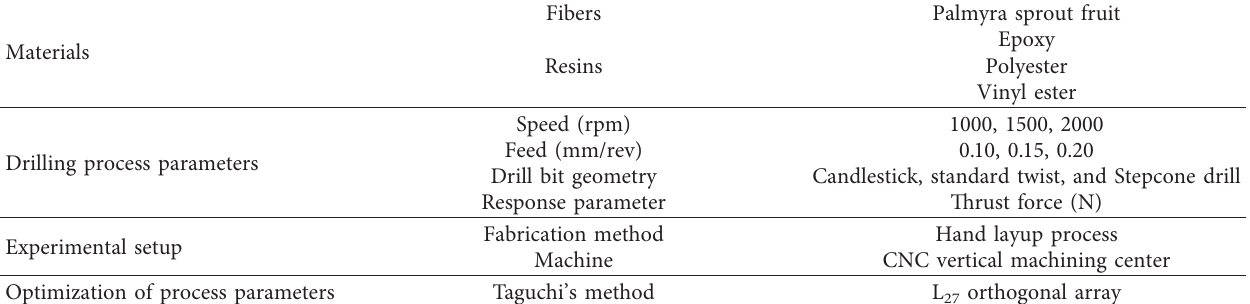
Table 1: Methodology of investigation on drilling process parameters of Palmyra based